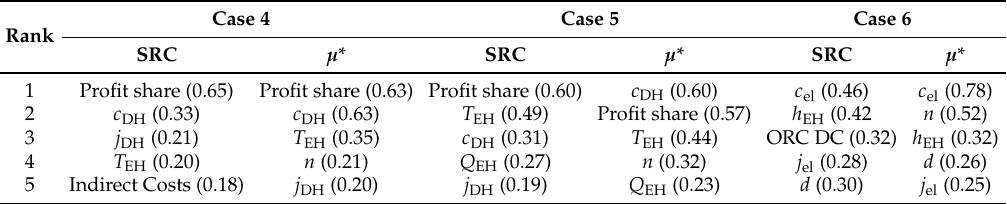
Table 9. Parameter significance ranking using linear regression of the MC simulations and the Morris screening for the NPV of the last three case